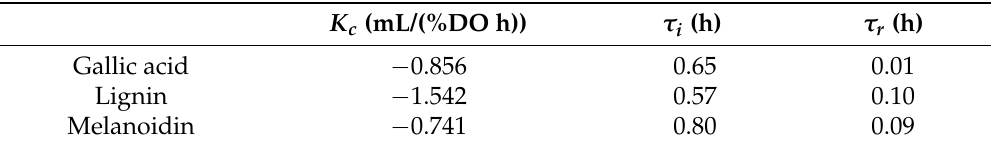
Table 4. Calculated PI controller parameters, and considered reference-trajectory time constants for each RC according to Equation (7).